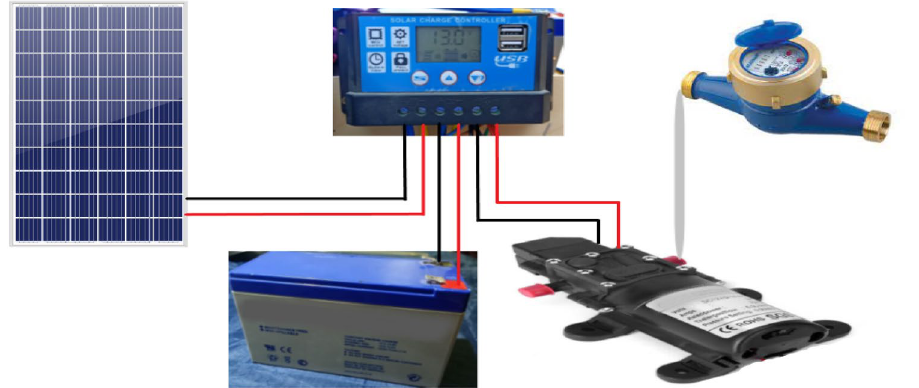
Figure 2. PV system block diagram: